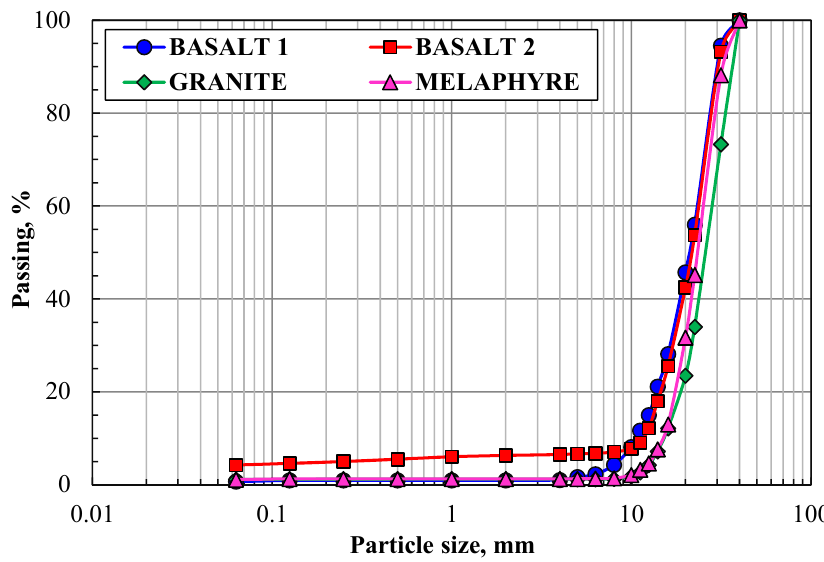
Figure 3. Particle size distribution of aggregates.